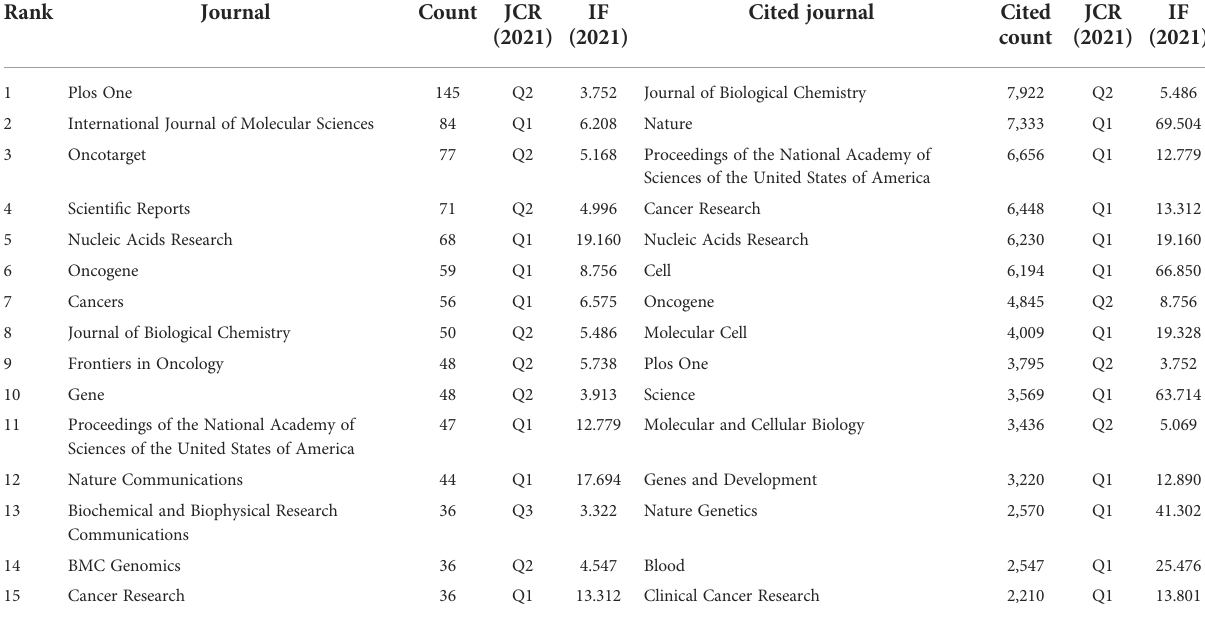
TABLE 3 Top 15 journals and co-cited journals related to alternative splicing of cancer.